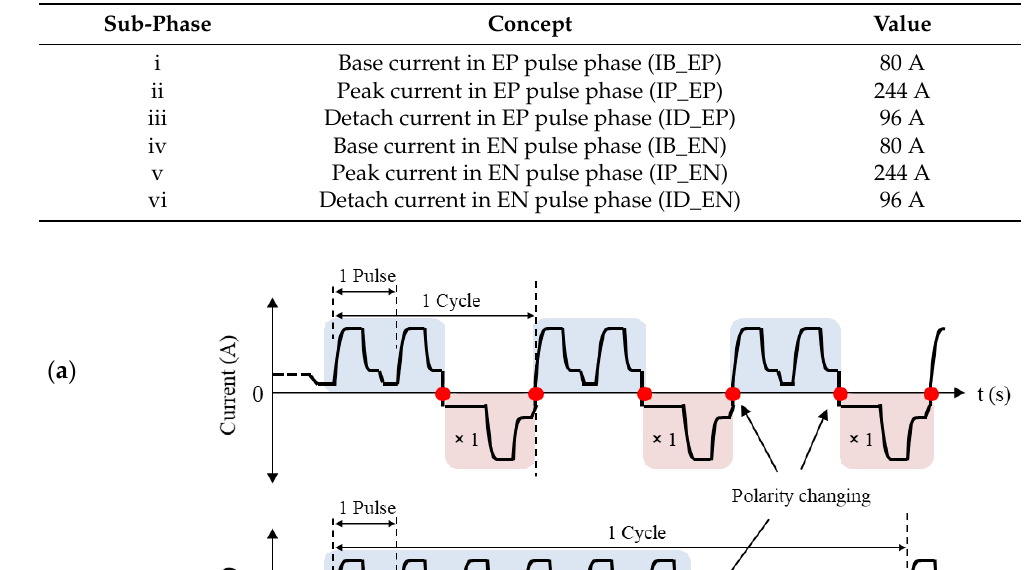
Figure 3. Current waveform schemes associated with an EN pulsing ratio of 0.33, with variable rep- etition in ( a ) one and ( b ) three times.